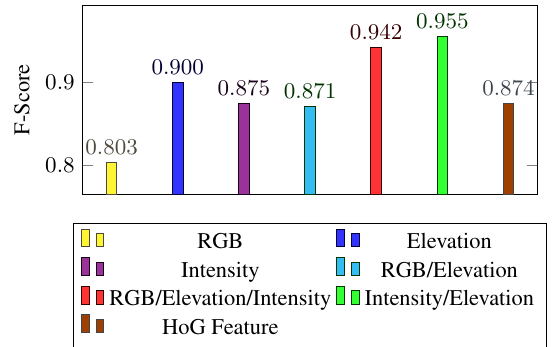
Figure 11. F-Scores for the training results derived by different data of the Medium-CNN with the HoG feature classification result for comparison.